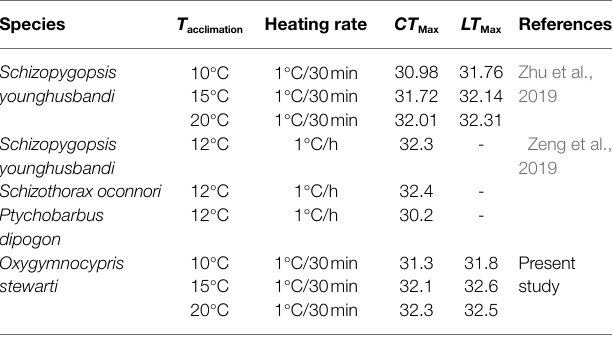
TABLE 5 | Thermal tolerance of O. stewarti and other reported Tibetan fishes.